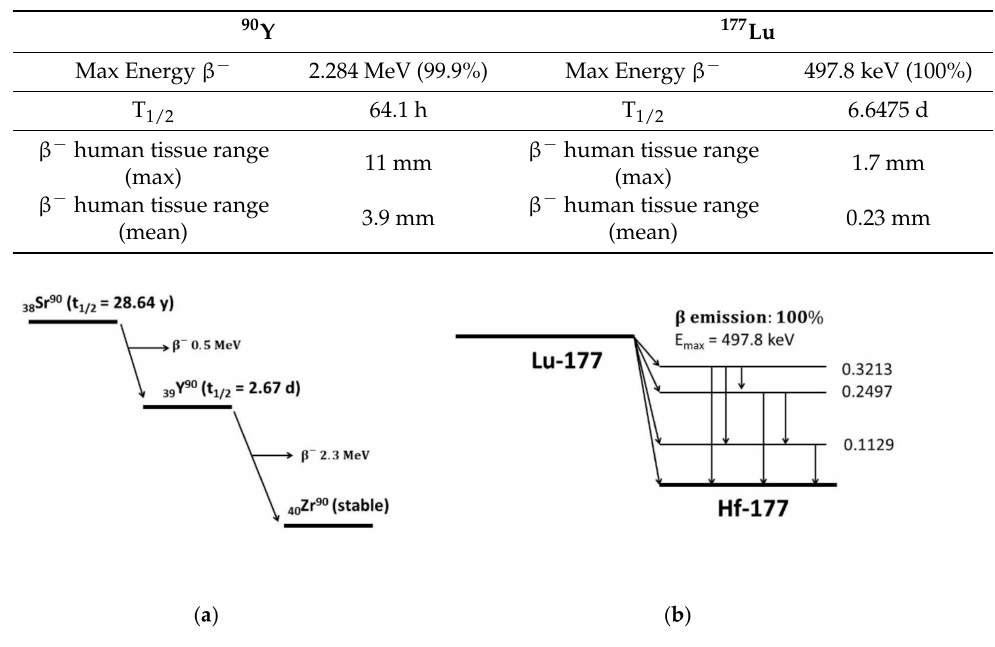
Figure 3. Decay schemes of 90 Y ( a ) and 177 Lu ( b